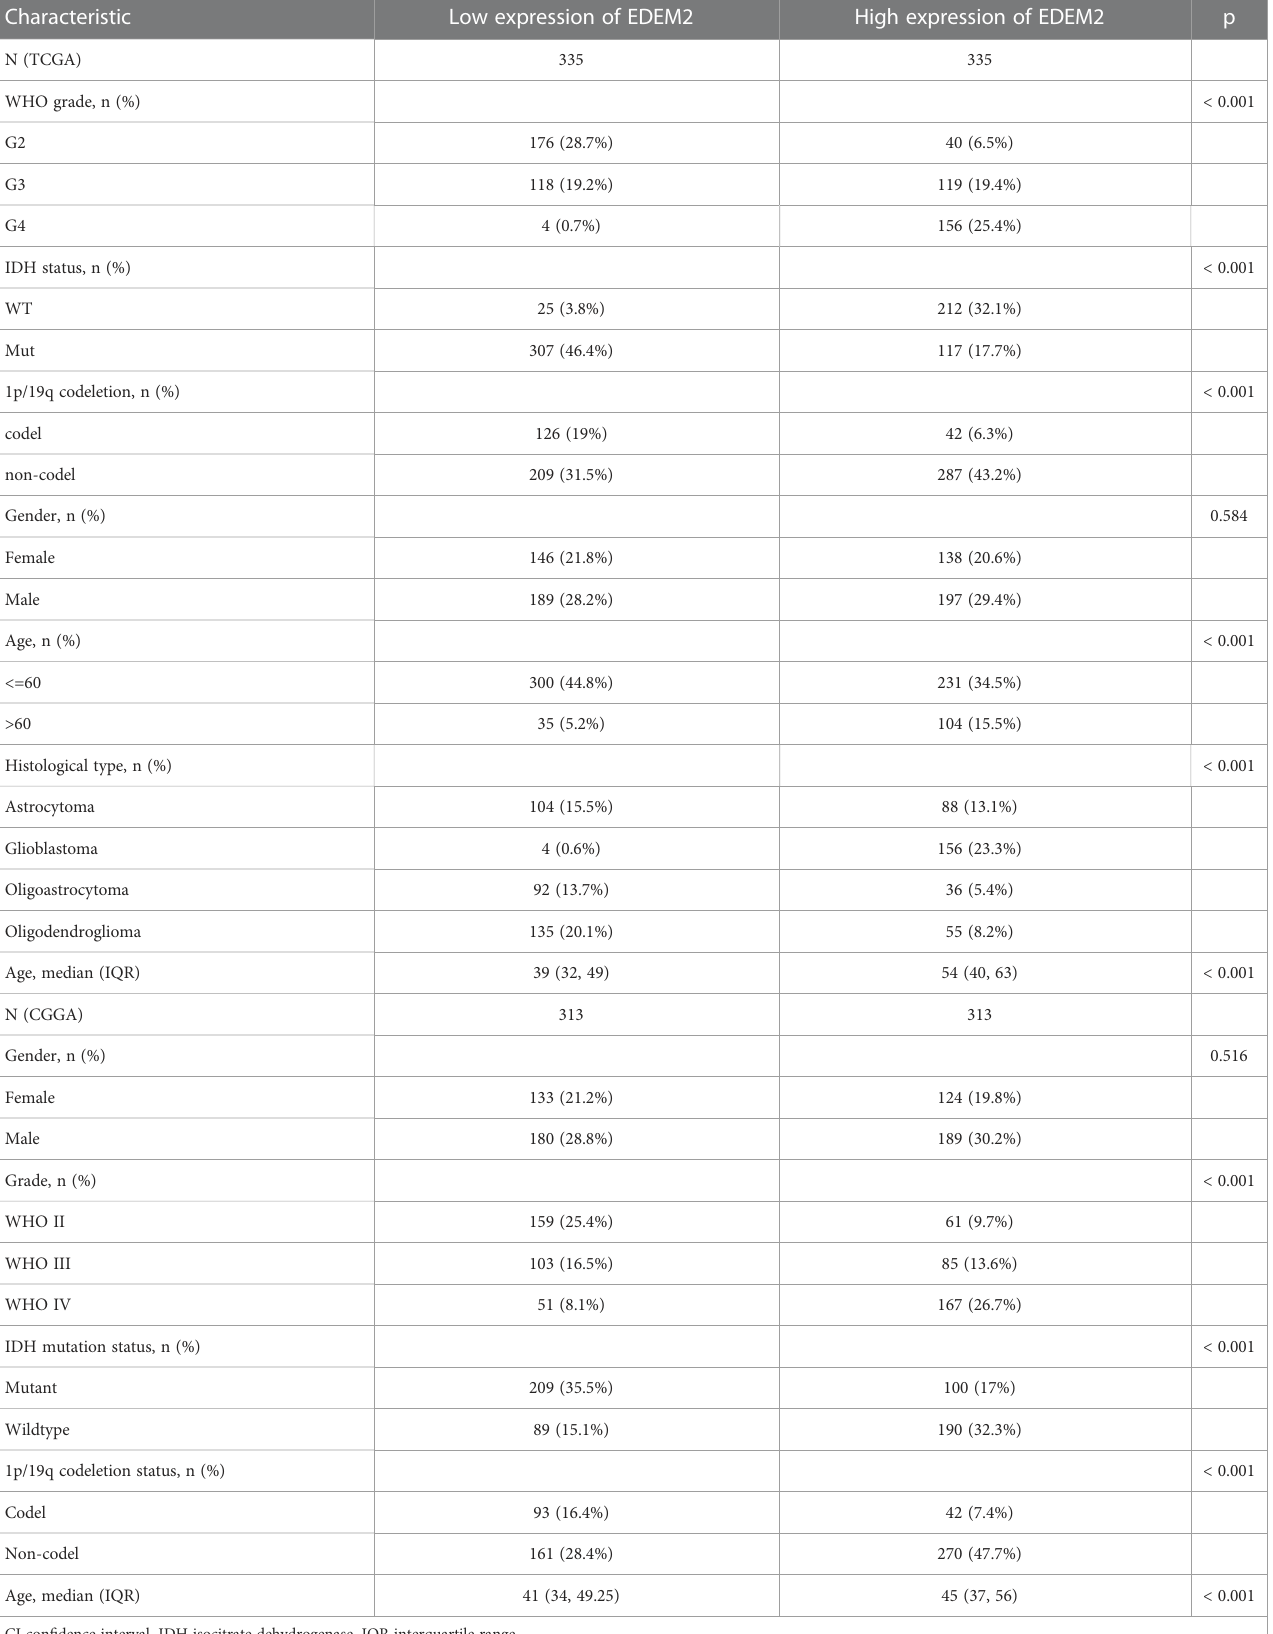
TABLE 1 Clinicopathological features of the two groups in the TCGA and CGGA cohorts.